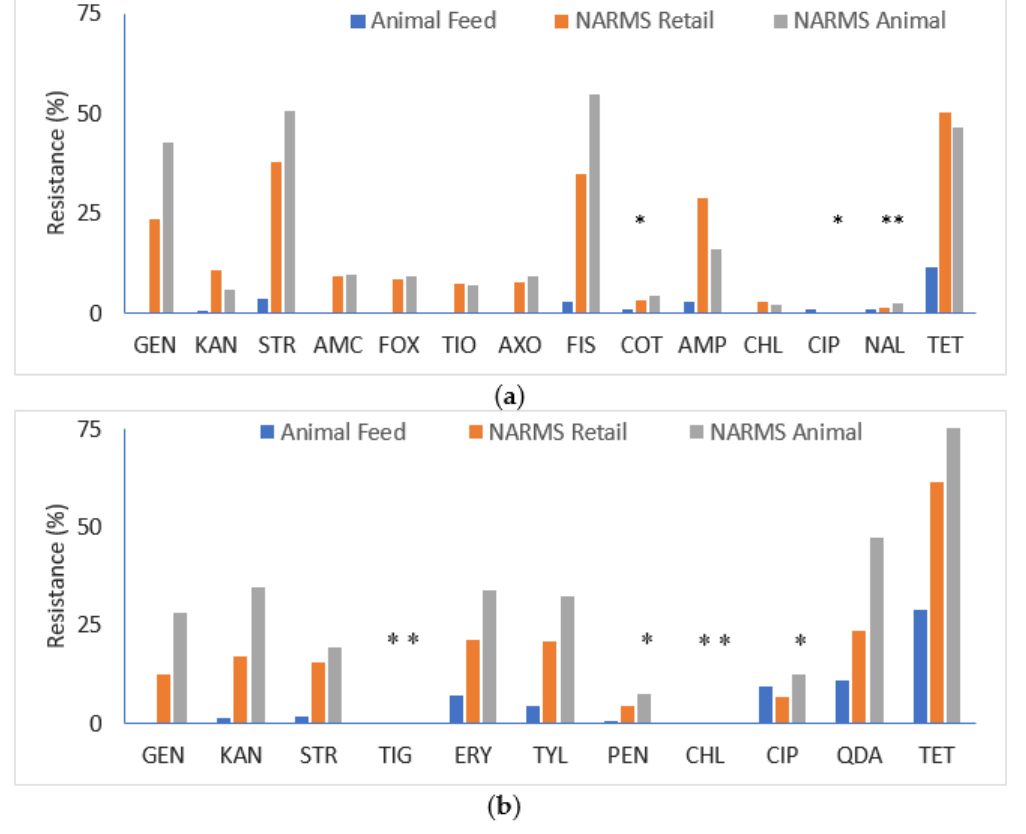
Figure 2. AMR of E. coli and Enterococcus spp. compared with NARMS 2011 retail meat and animal data. Each asterisk above the bar (*) indicates insignificant di ff erences in resistance rate between isolates recovered from animal food and those from NARMS retail meat or NARMS animal. ( a ) E. coli ; ( b ) Enterococcus spp. Abbreviations for antimicrobials are in ( a ): GEN, gentamicin; KAN, kanamycin; STR, streptomycin; AMC, amoxicillin-clavulanic acid; FOX, cefoxitin; TIO, ceftiofur; AXO, ceftriaxone; FIS, sulfisoxazole; COT, trimethoprim-sulfamethoxazole; AMP, ampicillin; CHL, chloramphenicol; CIP, ciprofloxacin; NAL, nalidixic acid; and TET, tetracycline; and in ( b ) GEN, gentamicin; KAN, kanamycin; STR, streptomycin; TIG, tigecycline; ERY, erythromycin; TYL, tylosin; PEN, penicillin; CHL, chloramphenicol; CIP, ciprofloxacin; QDA, quinupristin / dalfopristin; and TET, tetracycline. Antimicrobials not shown are amikacin for E. coli , and daptomycin, linezolid, nitrofurantoin, and vancomycin for Enterococcus spp. due to no resistance and / or unavailable NARMS 2011 data (amikacin and